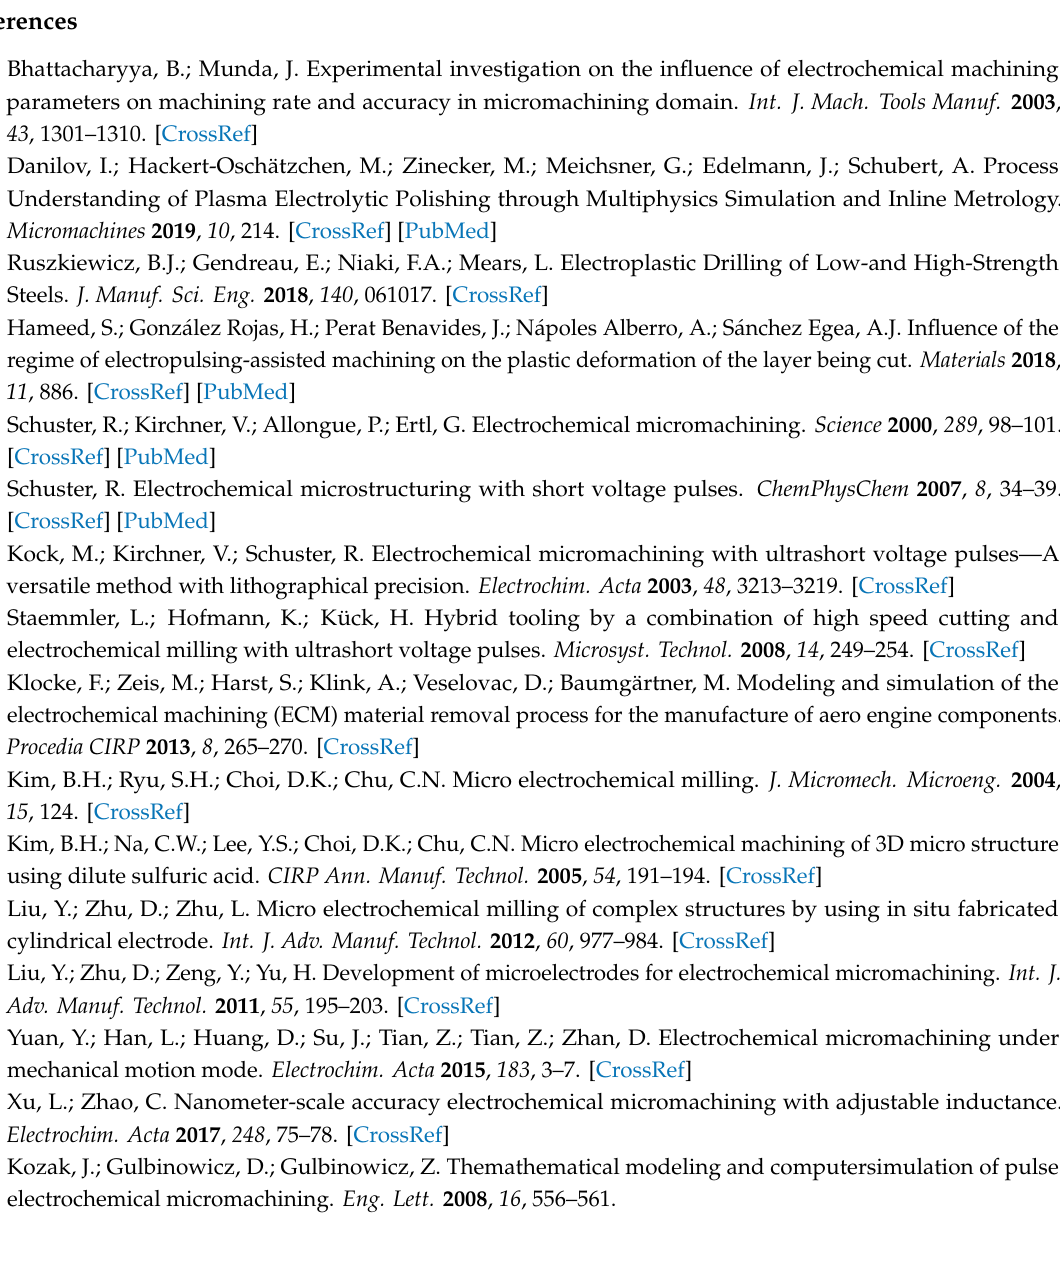
Figure S1: Gas-liquid distribution in micro machining gap by use of the helix micro electrode with di ff erent rotating